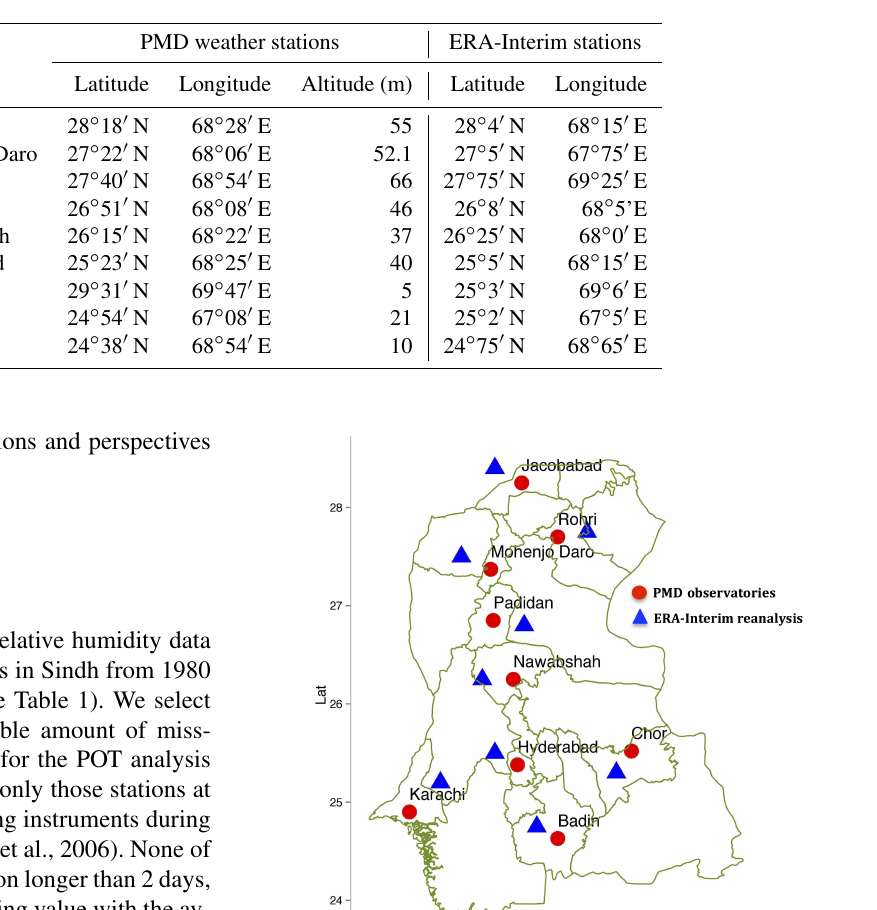
later in the paper and then average the results. We check the influence of this noise parameterization and find no signifi- cant bias in the RL estimates. The advantage of adding noise is to avoid the spurious statistical effects associated with the presence of discrete values assigned to the temperature read- ings. Using the described bootstrap method, we reduce such problems without biasing the data.